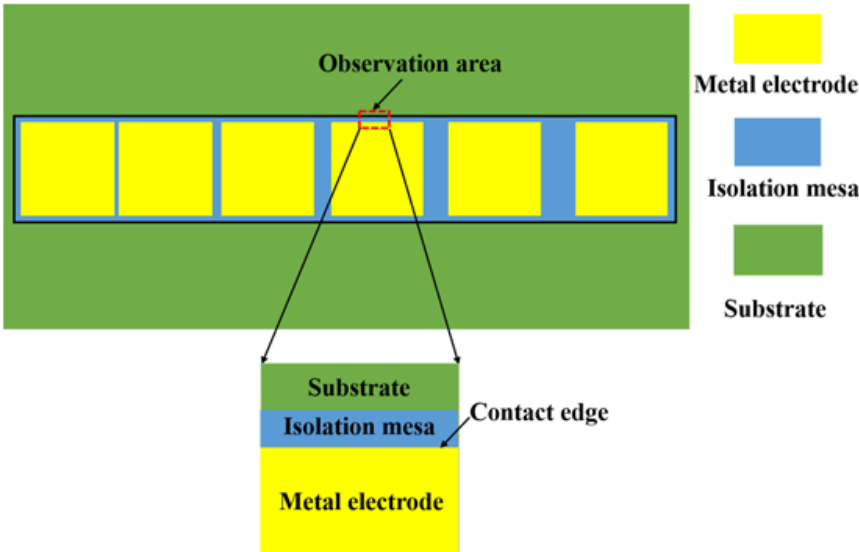
Figure 9. Schematic diagram of electrode edge area scanned by SEM.